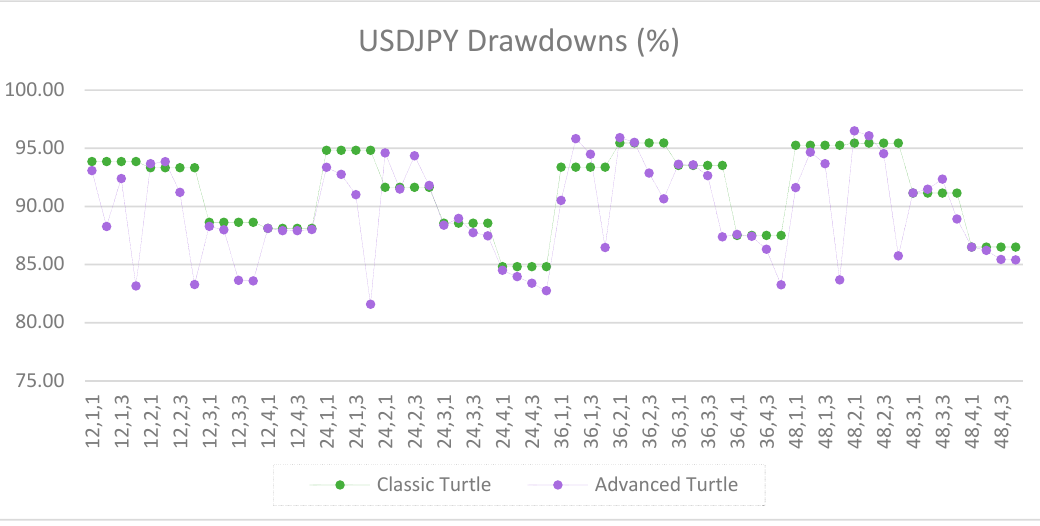
Figure A26. Drawdowns of USDJPY as percentage of equity between the classic and the advanced Turtle systems for every combination of N, X, Y for the medium parameters (40, 80).